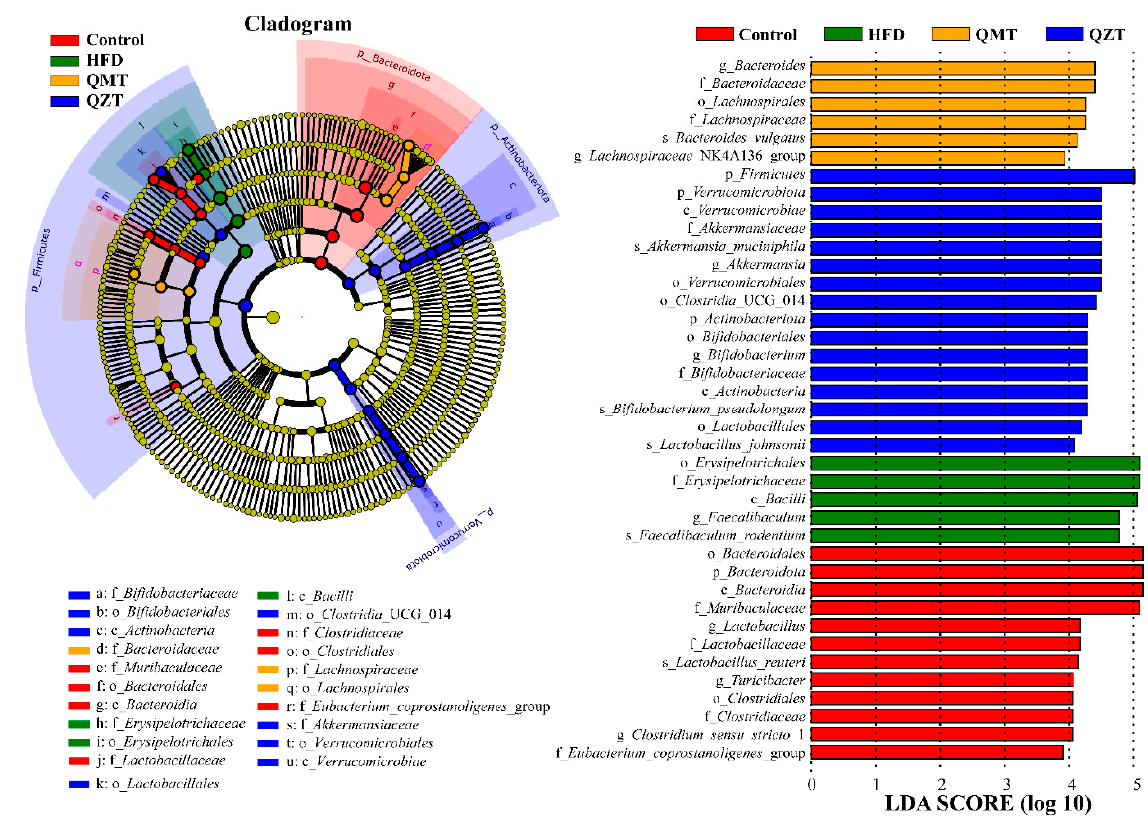
Figure 4. Taxonomic cladogram showed the most differentially abundant taxa in response to HFD, QMTe, and QZTe intervention. Foods 2022 , 11 , x FOR PEER REVIEW